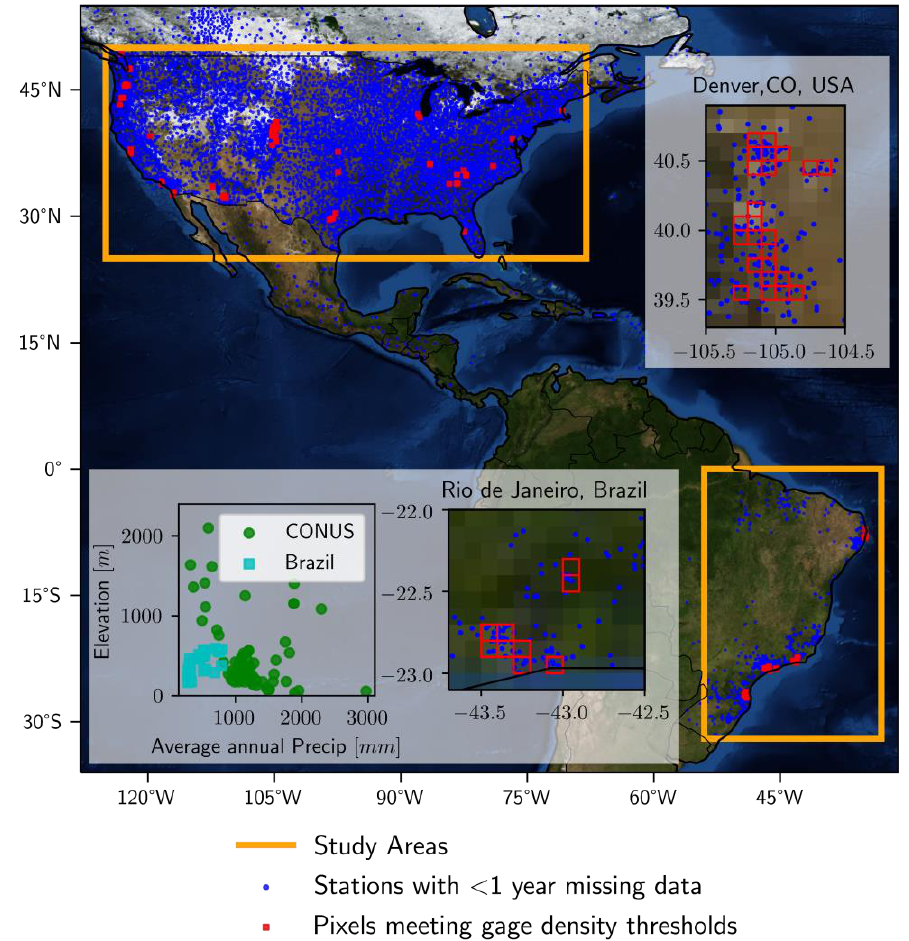
Figure 1. Map of study areas (orange) and gauge datasets used in this work (blue). Pixels that met gauge density requirements as described in Section 3.1 are overlayed (red). Subsets of the study areas near Denver, Colorado and Rio de Janeiro at closer scale are also shown to illustrate gauge network configurations in these regions. The elevation and average annual precipitation of pixels in CONUS and Brazil is also shown. The spread in elevation and annual precipitation is greater in CONUS than Brazil.